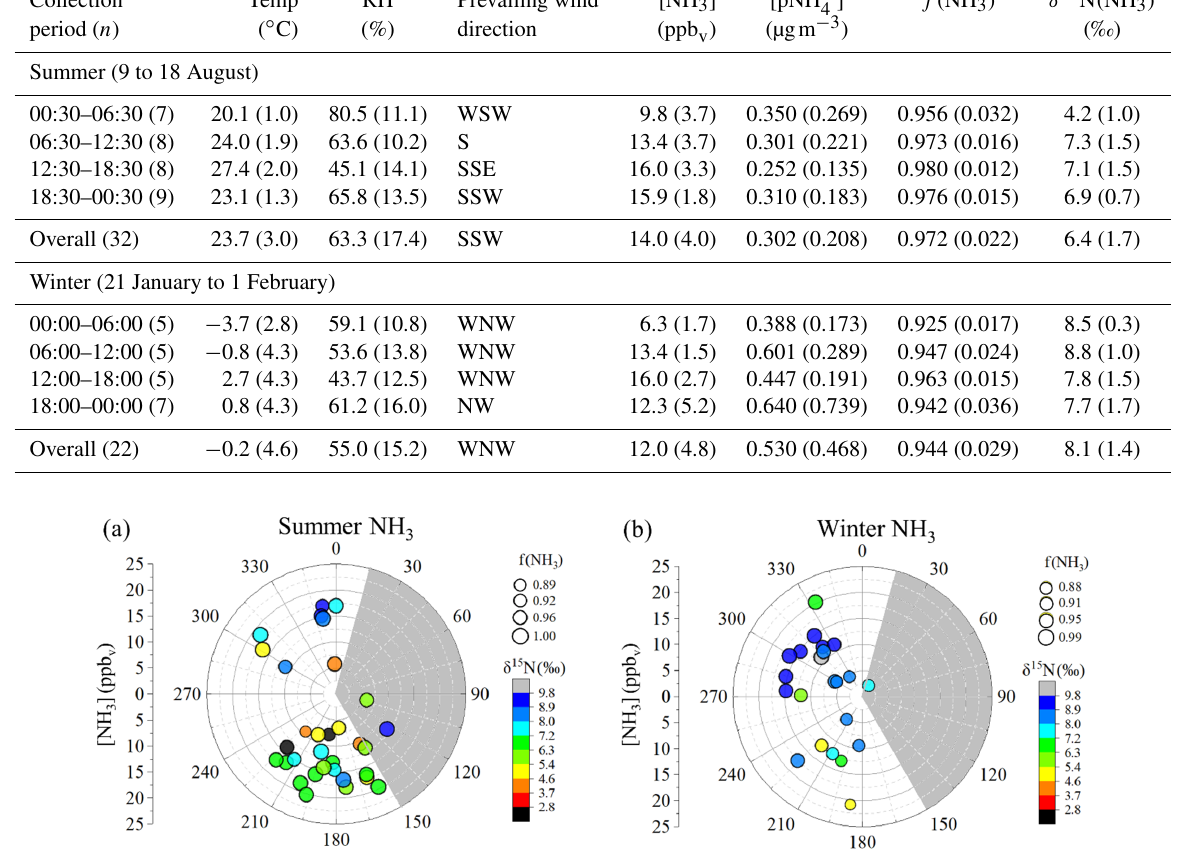
Table 2. Summary of the near-highway (Providence, RI, USA) environmental conditions including temperature (Temp), relative humidity (RH), wind direction, and NH x data including [ NH 3 ] , [ pNH + both summer and winter. Data are reported as x( ± 1 σ) for each collection period during summer and winter, respectively. The number of collections made during each collection period ( n ) is indicated.